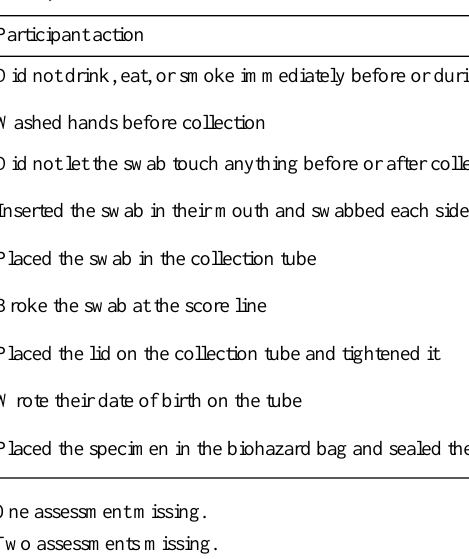
Table 6. Clinician-documented participant actions when collecting oropharyngeal swabs and conducting COVID-19 self-testing in the iCollect study